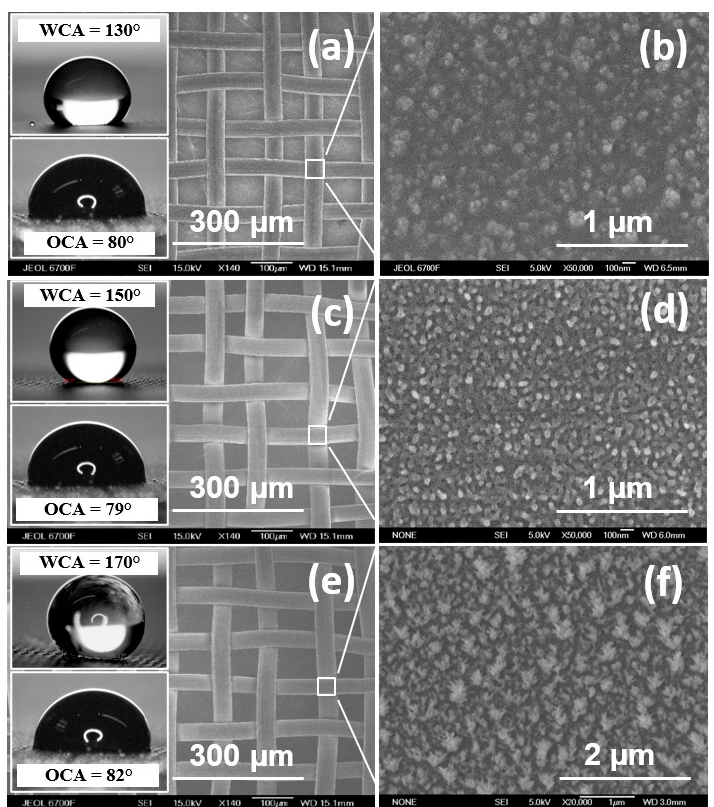
Figure 1. Micrograph of the surface of membranes with various fluoropolymer coatings: ( a , b ) Type 1, ( c , d ) Type 2, and ( e , f ) Type 3. Insets include WCA values and photographs of water and oil droplets on the membrane surface.